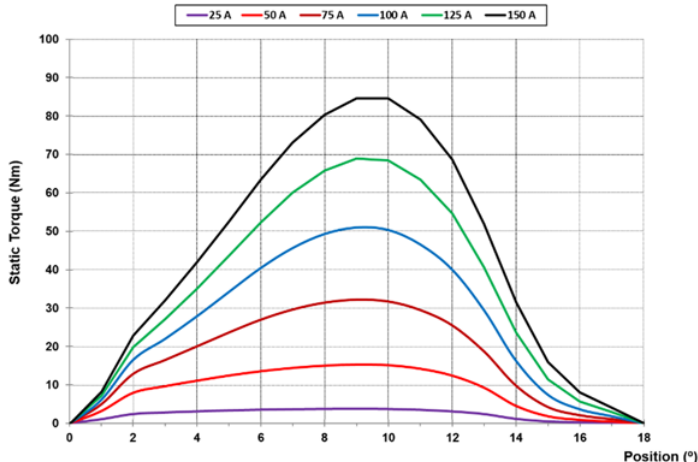
Figure 15. Static torque curves for AFSRM prototype.